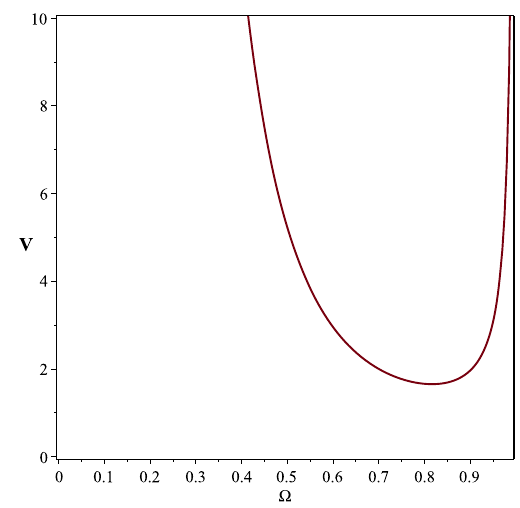
Fig. 1 Schematic plot of the radial coordinate r versus the scalar field (cid:16)